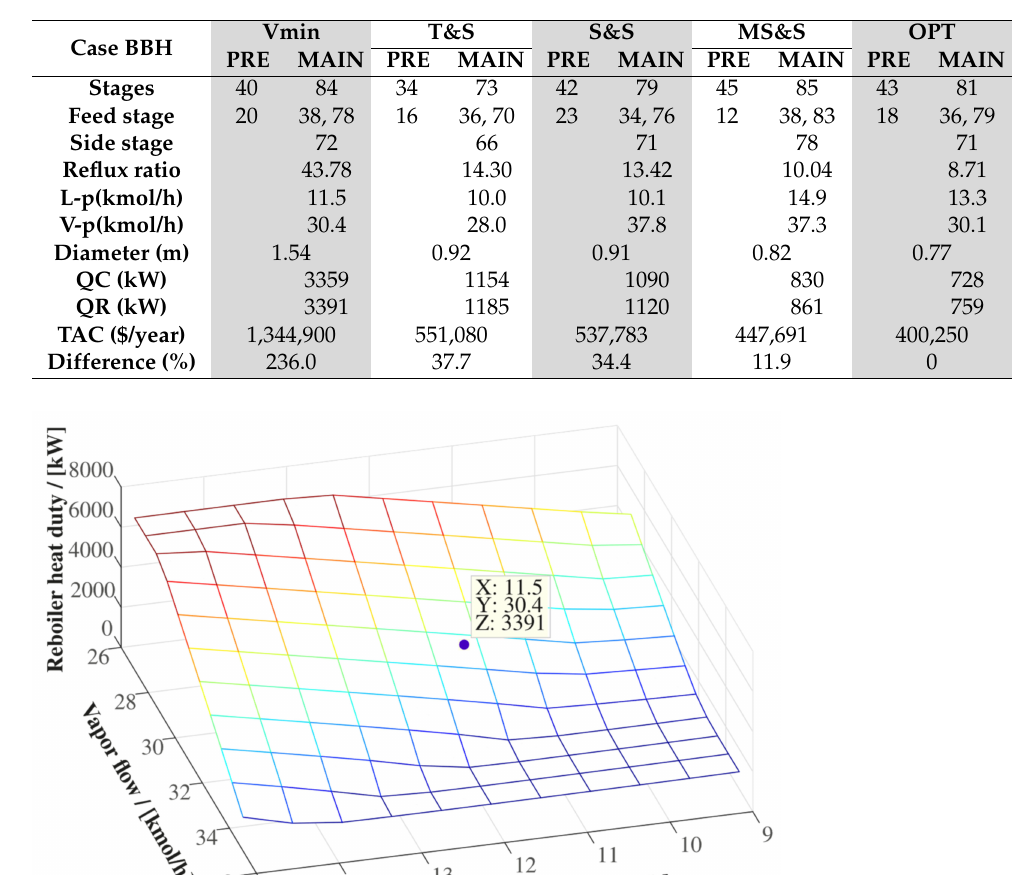
Table 5. Results for the i-butane, n-butane, and n-hexane (BBH) mixture.